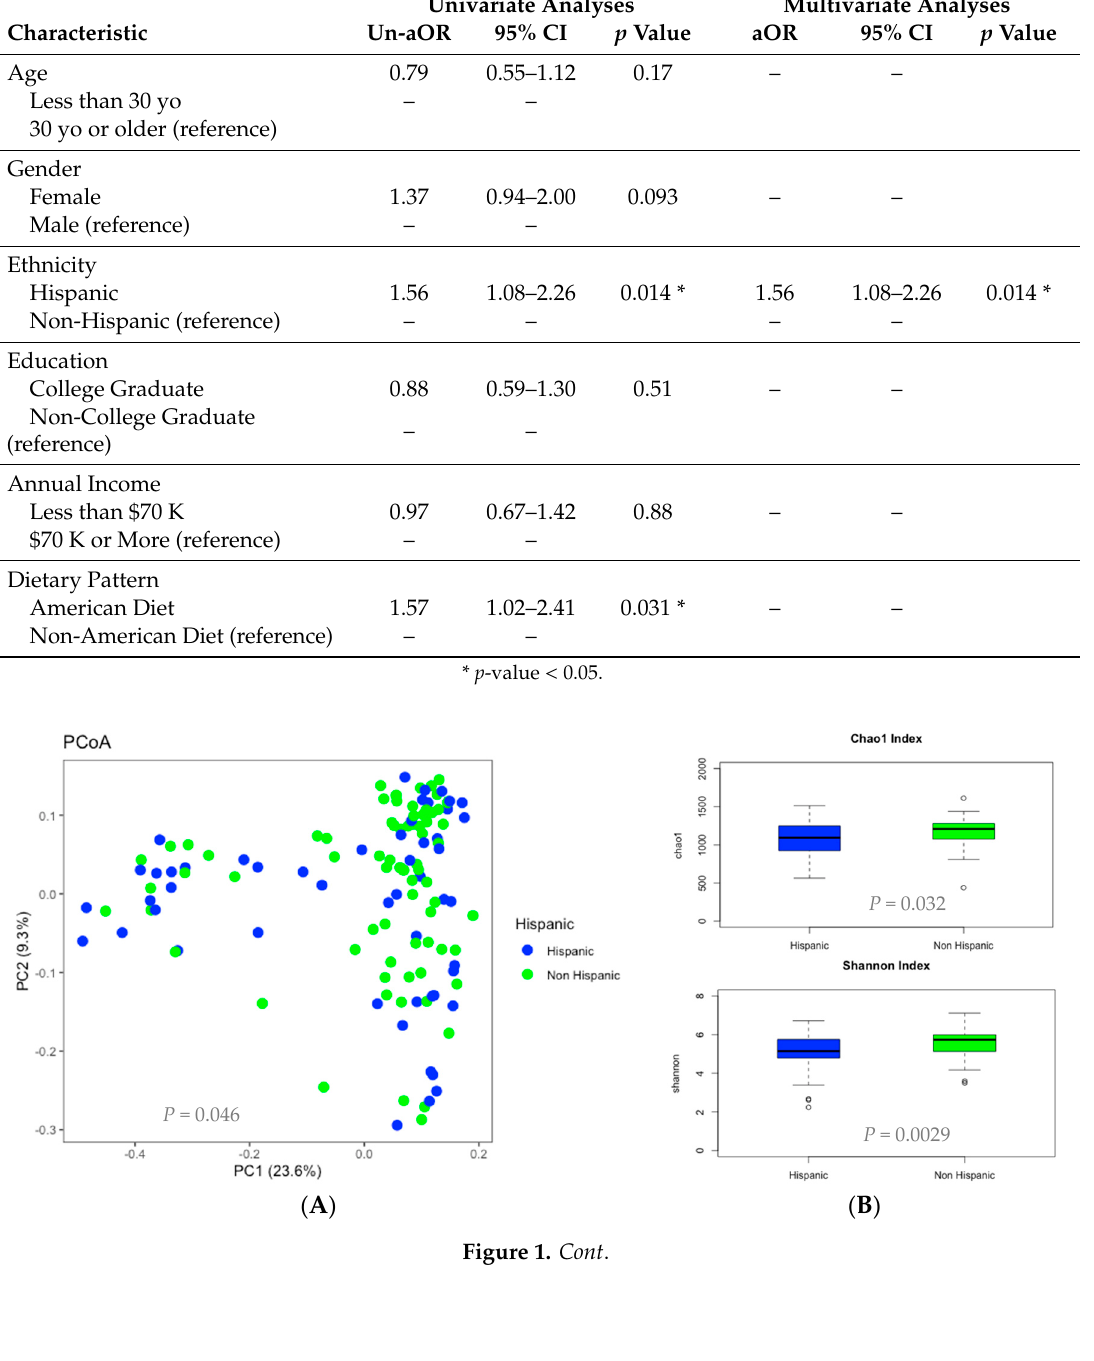
( C ) Figure 1. Microbial Profiles of Hispanic versus Non-Hispanic. ( A ). Beta Diversity. Principal coordinates analysis plots of microbial composition of Hispanic vs. Non-Hispanic. p -value is shown for the difference in root square Jensen-Shannon divergence distance matrix. ( B ). Alpha Diversity. Chao1 and Shannon Indexes illustrated in box plots of Hispanic vs. Non-Hispanic. ( C ). Differential expression of microbial genera (Phylum: (Genus)) associated with Hispanic vs. Non-Hispanic. Positive log2 fold change favor association to Hispanics in the following microbiome: Bacteroidetes : 107,044 ( Alistipes ), 524,371 ( Prevotella ), 1,944,498 ( Bacteroides ), 588,929 ( Prevotella ), 213,566 ( Bacteroides ).